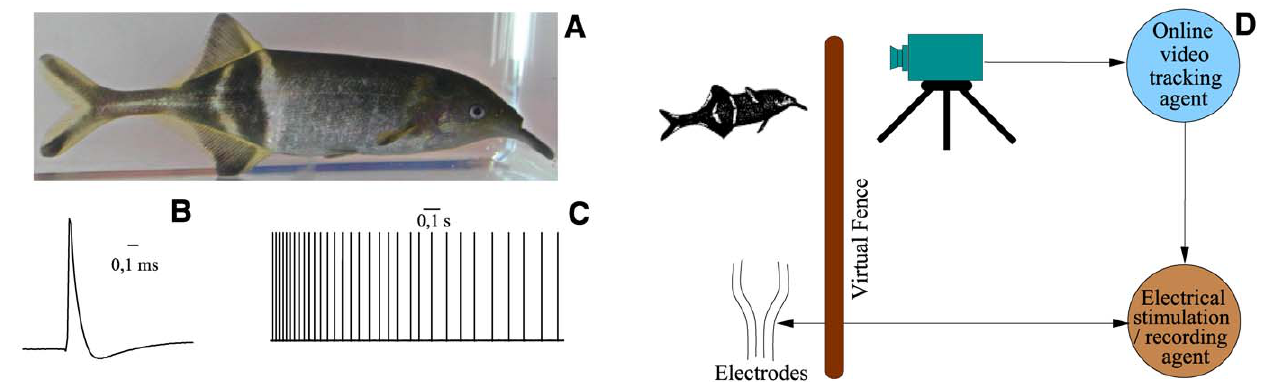
Figure 5. Closed-loop video-event driven stimulation. A: Electric fish Gnathonemus petersii . B: Single electrical organ discharge of this fish. C: a typical train of activity (signals are squared in this plot). D: Schematic representation of the closed-loop video-event driven stimulation.